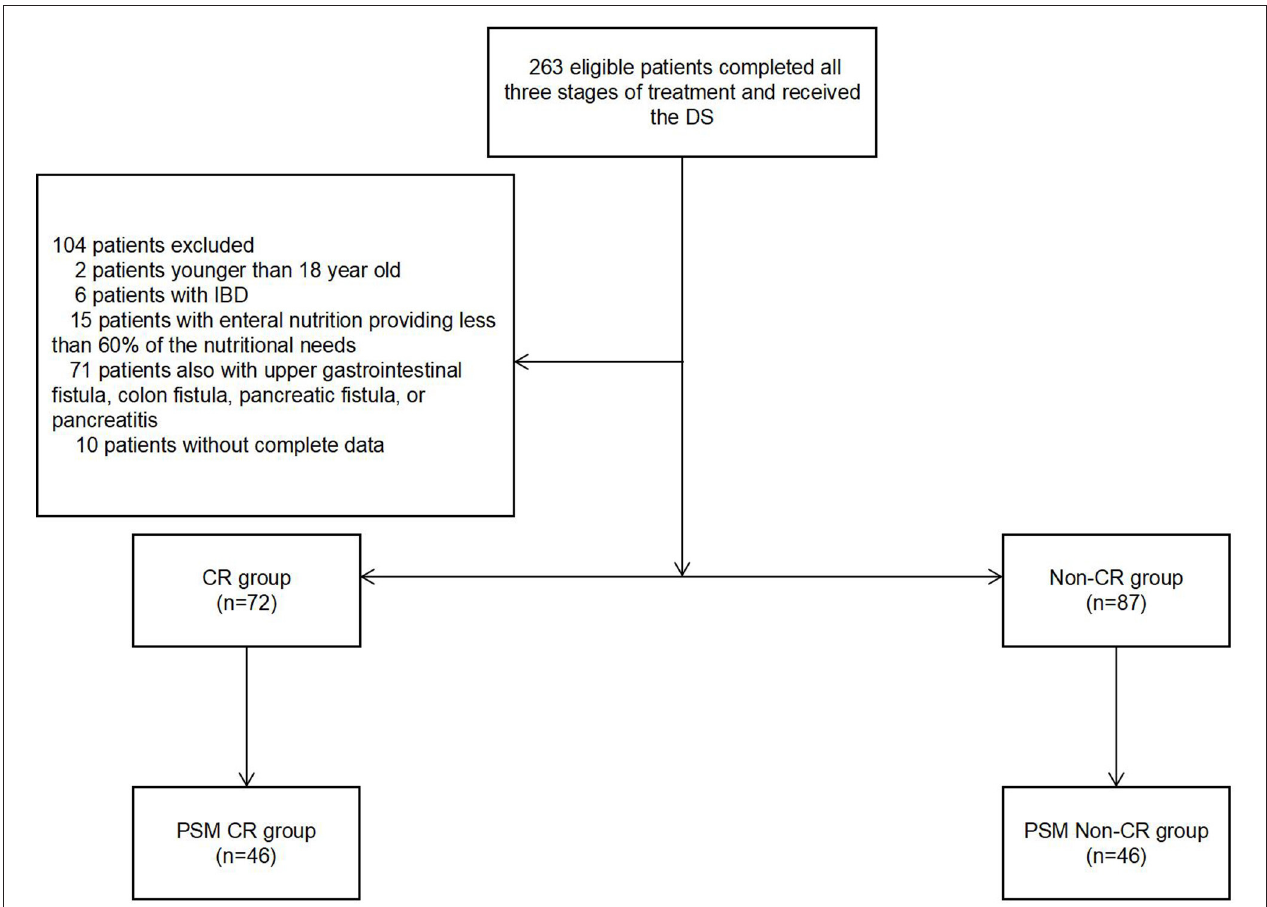
FIGURE 1 | The patients and